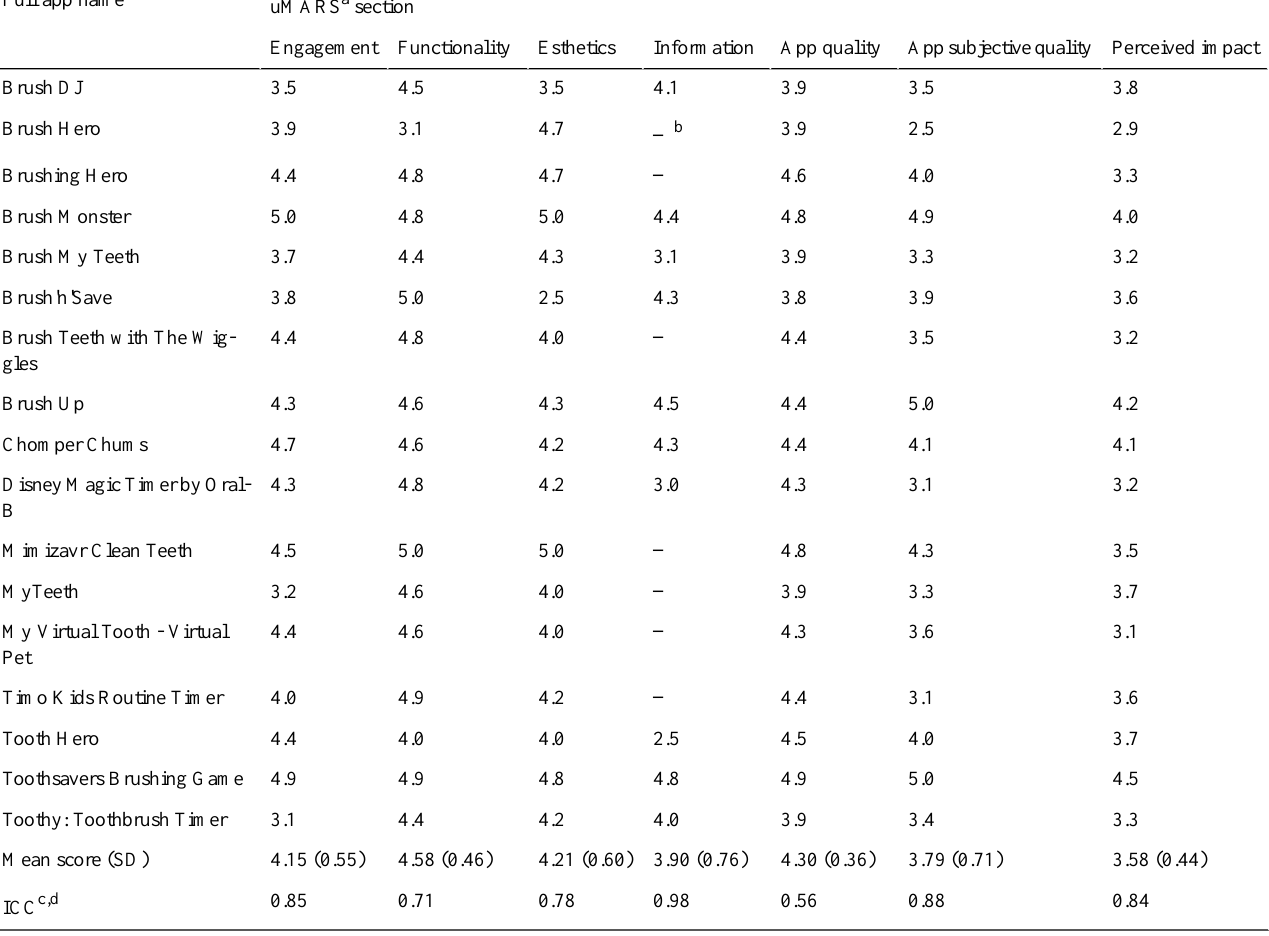
Table 2. App scores for each section of the Mobile App Rating Scale user